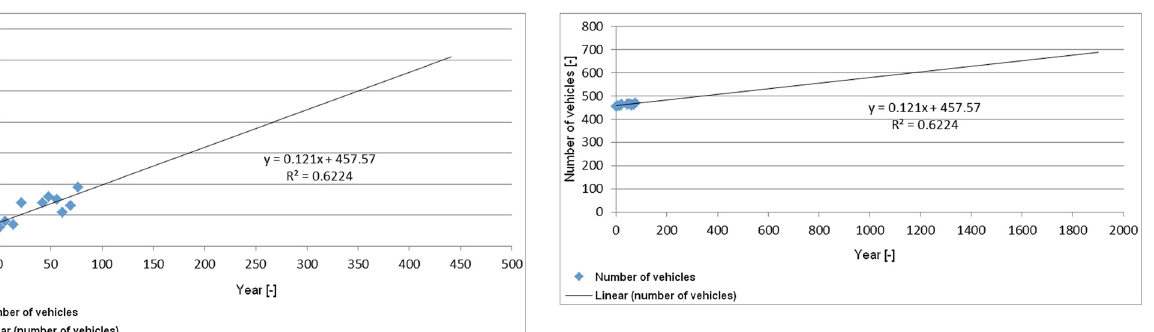
Figure 4: Parking demand forecast for 5